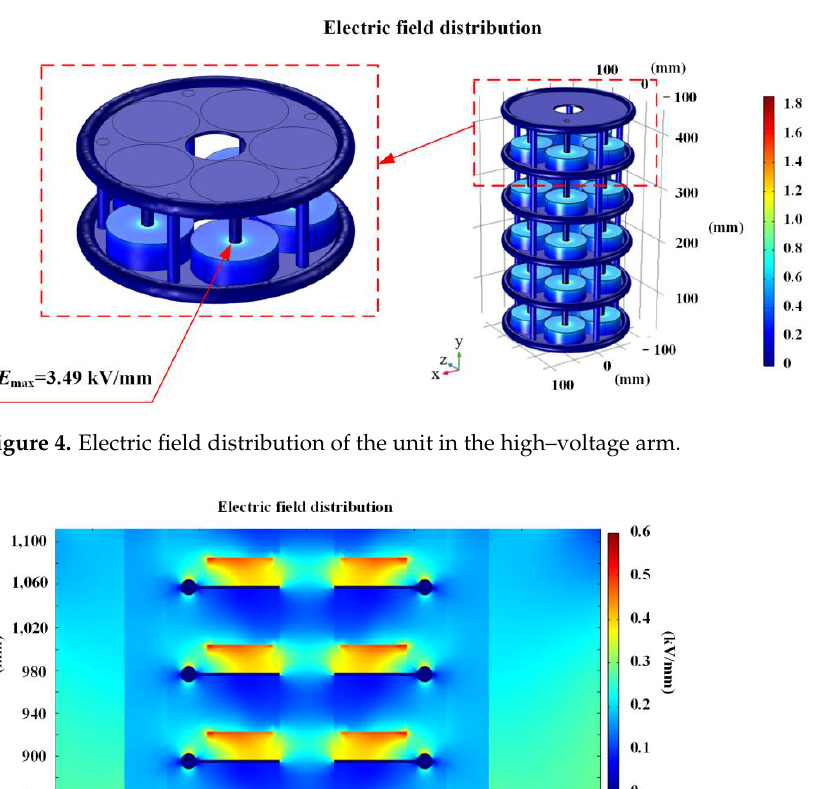
Figure 3. Electric field distribution of the high – voltage arm.